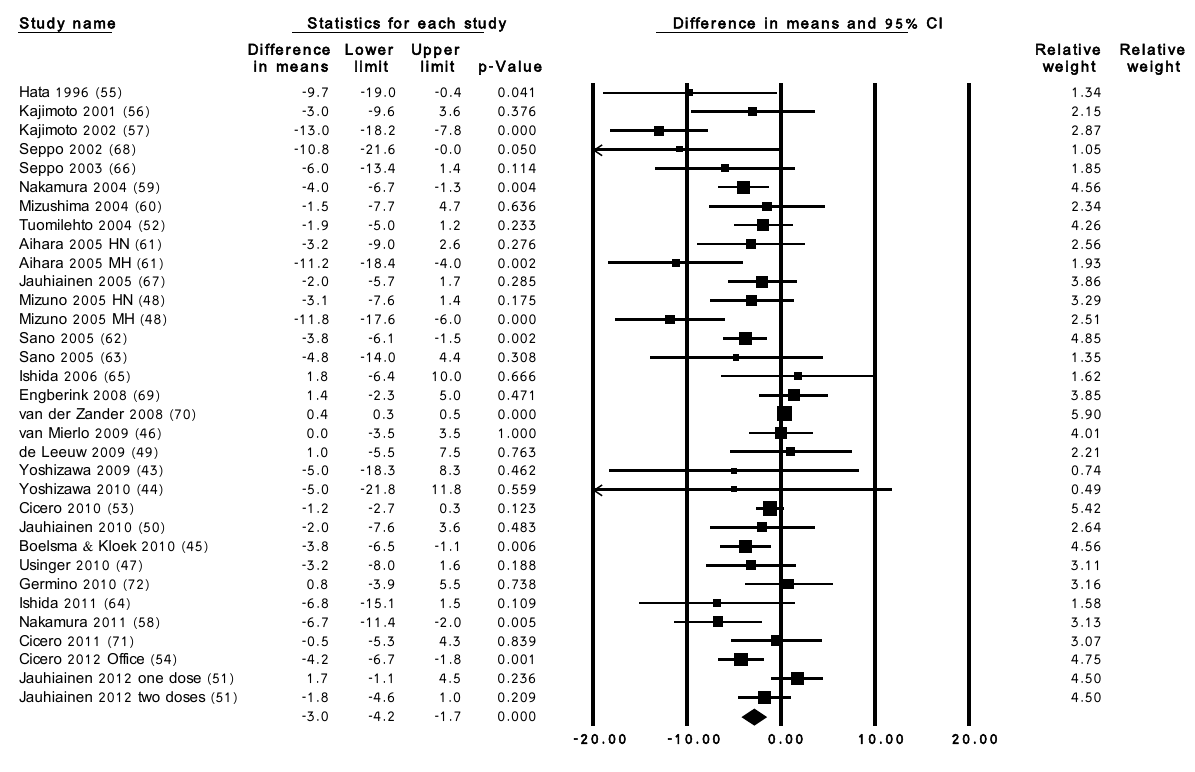
Figure 1. Overall change in SBP (mmHg) after LTP supplementation. HN, high-normotensives; MH, mild-hypertensives; 0.000 refers to p<0.001. Weighted mean difference (95% CI), random effects model. Q = 141.01, df = 32, p < 0.001, I 2 =